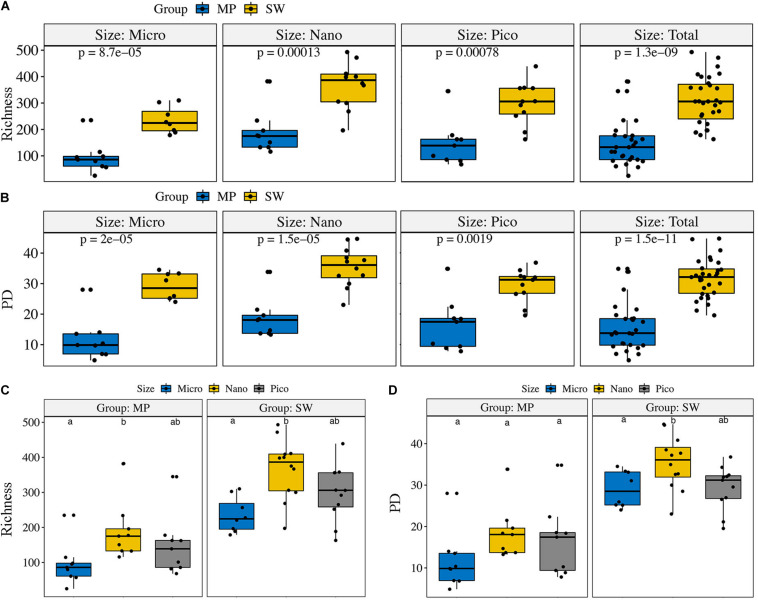
Alpha-diversity estimates (Richness and PD) for the size-fractionated (A,B) samples of the melt ponds (MPs) and sea water (SW) and for the pooled (C,D) MP and SW samples, respectively. The line in each box plot indicates the median, the box delimits the 25th and 75th percentile. Bars in (C,D) without shared letters indicate significant differences at the level of p = 0.05.